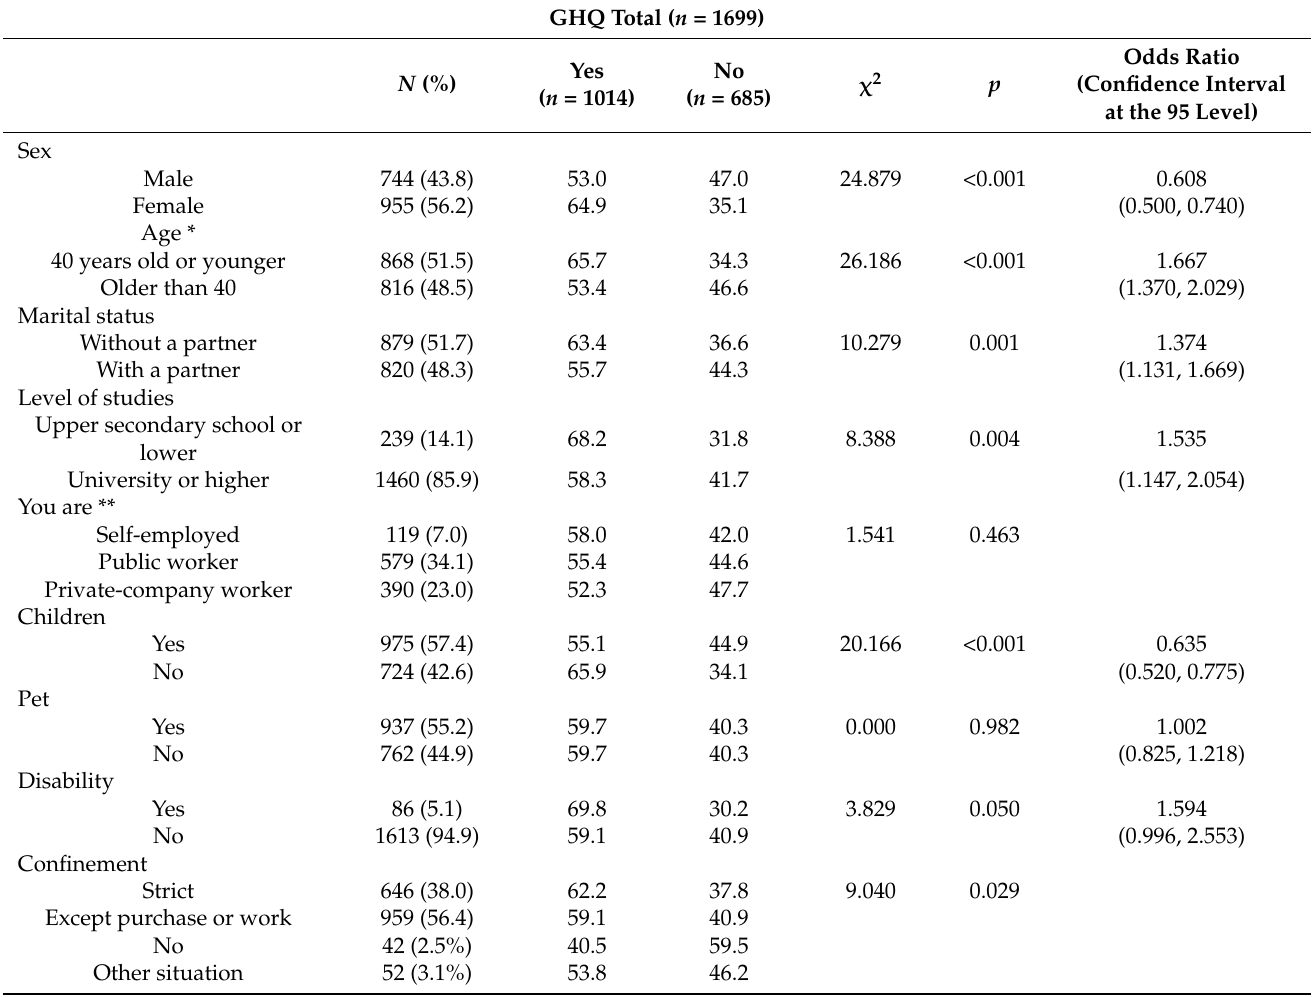
Table 1. Association between sociodemographic variables and psychological distress during the